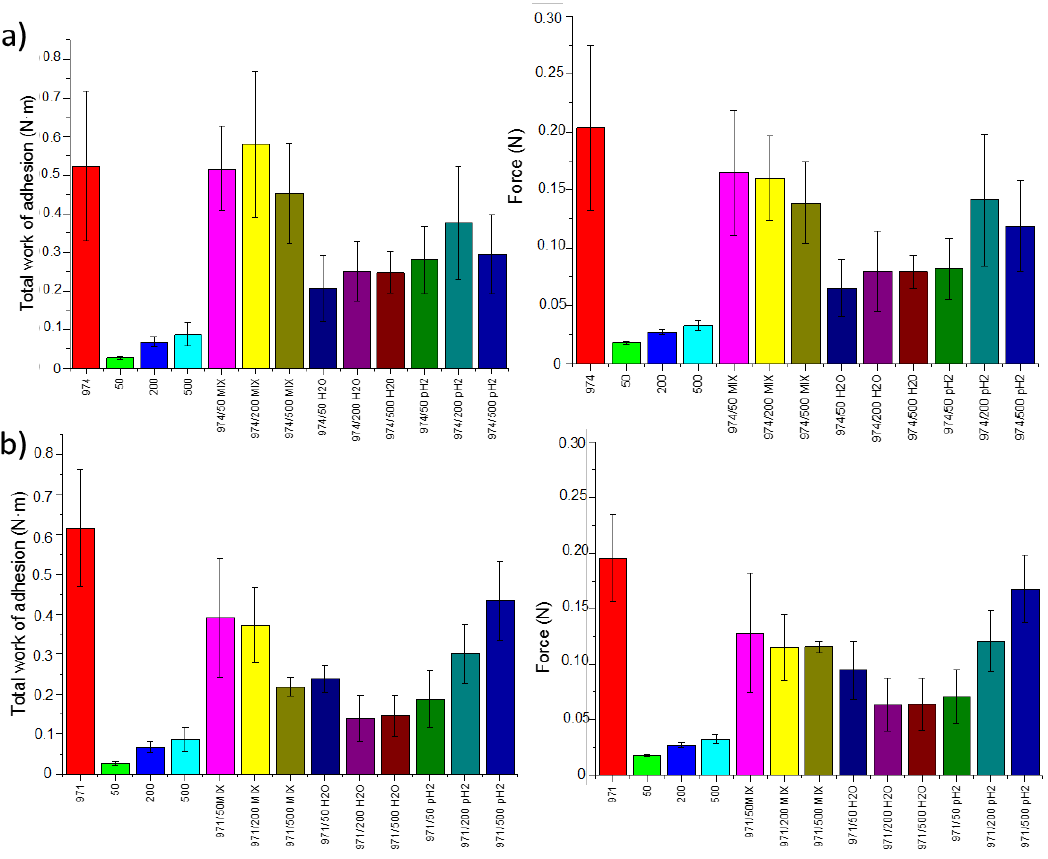
Figure 3. The total work of adhesion ( left ) and detachment force ( right ) on porcine buccal tissues at 37 °C for: ( a ) Carbopol 974/poly(2-ethyl-2-oxazoline) tablets; and ( b ) Carbopol 971/poly(2-ethyl- oxazoline) tablets.